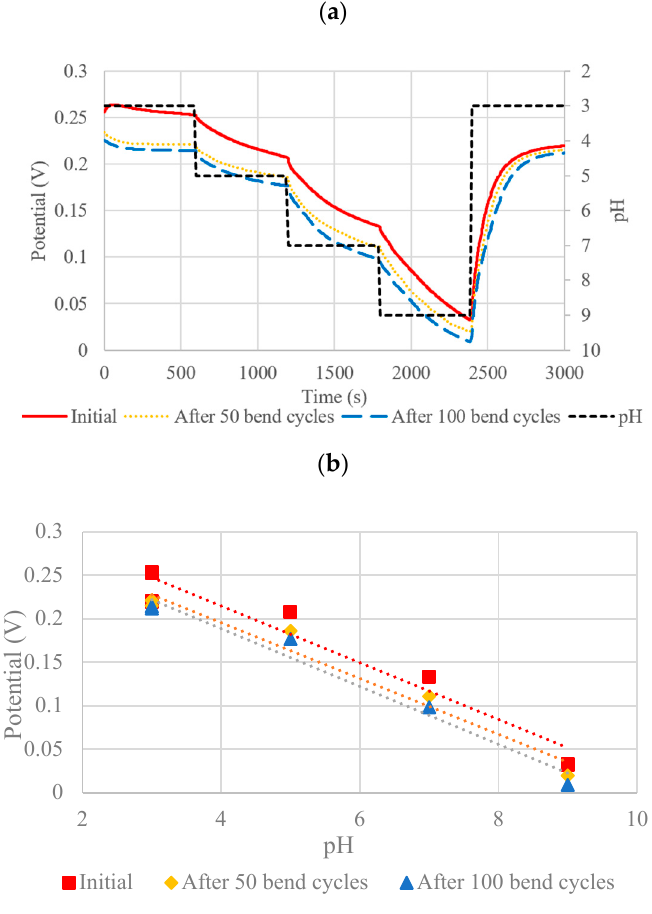
Figure 16. ( a ) OCP pH Response of PANI-ES + DBSA + Speedball composite after 50 and 100 bend cycles and ( b ) corresponding sensitivity curves. Table 3. Curve-fitting, linearity, and sensitivity data corresponding to Figure 16.